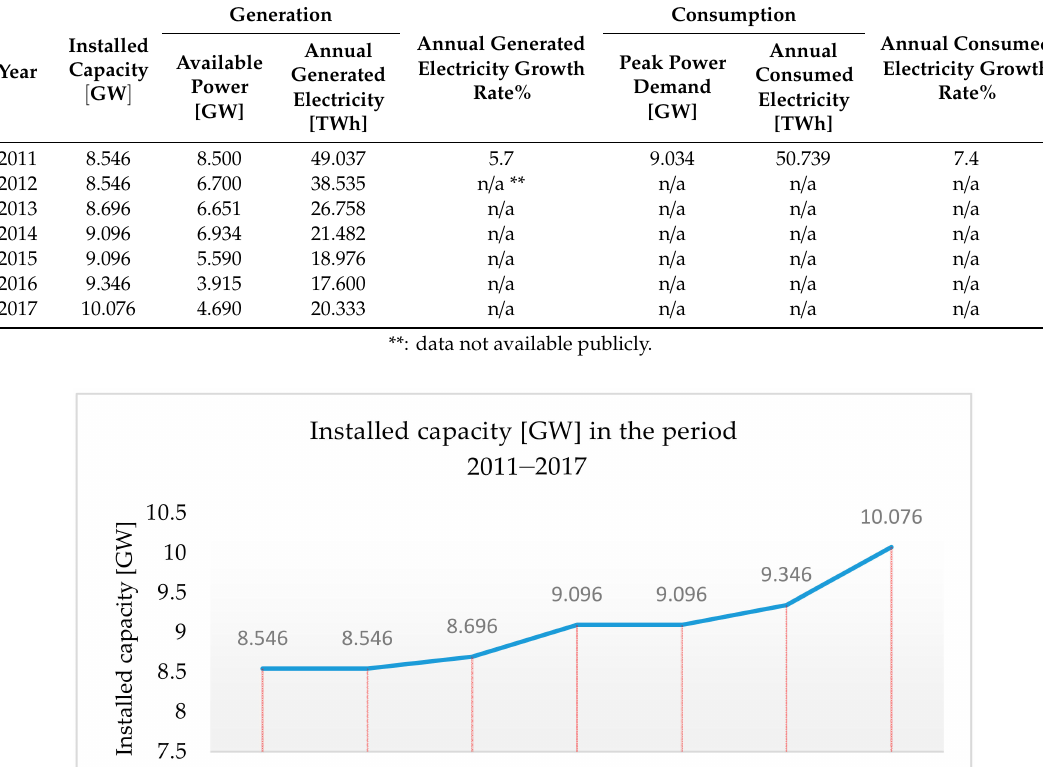
Table 6. Installed capacity, available power, generated energy, peak demand, and consumed energy of the SEPS in the period (2011–2017).